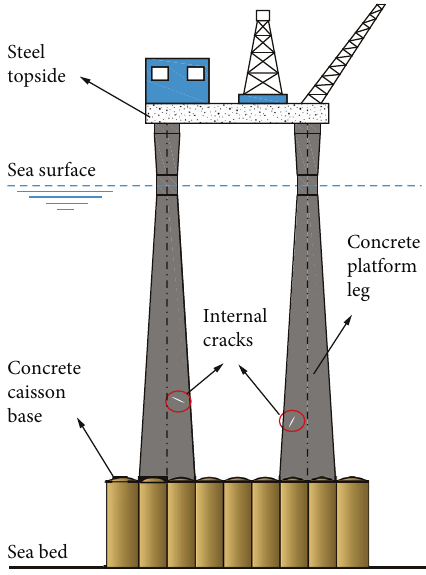
Figure 1: The oil platform with concrete legs and concrete base installed on the seabed.